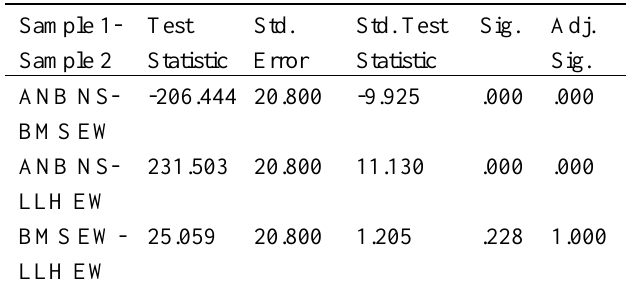
Pairwise Comparison summary of difference in illuminance of the different